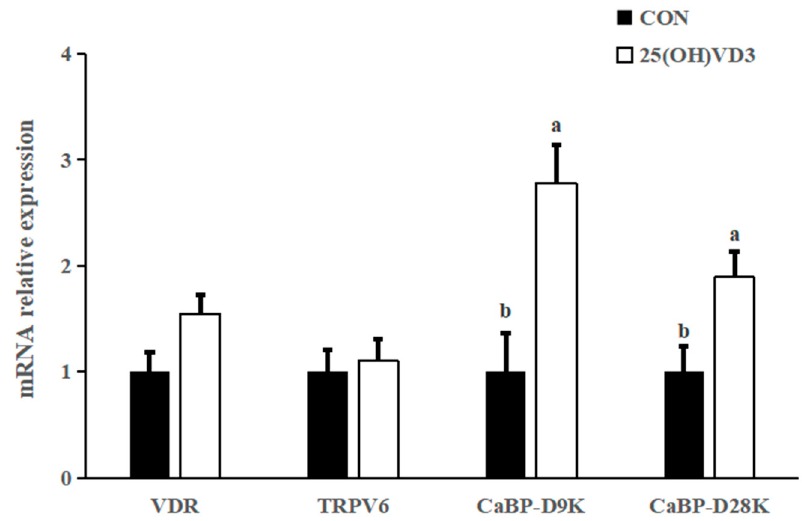
Figure 3. Effects of 50 µ g/kg 25(OH)VD3 on the mRNA expression of calcium ion channel proteins in the liver of finishing pigs. Note: Superscript letters within the bar chart indicate significant differences ( p < 0.05), n = 6. 25(OH)VD 3 , 25-hydroxyvitamin D 3 .